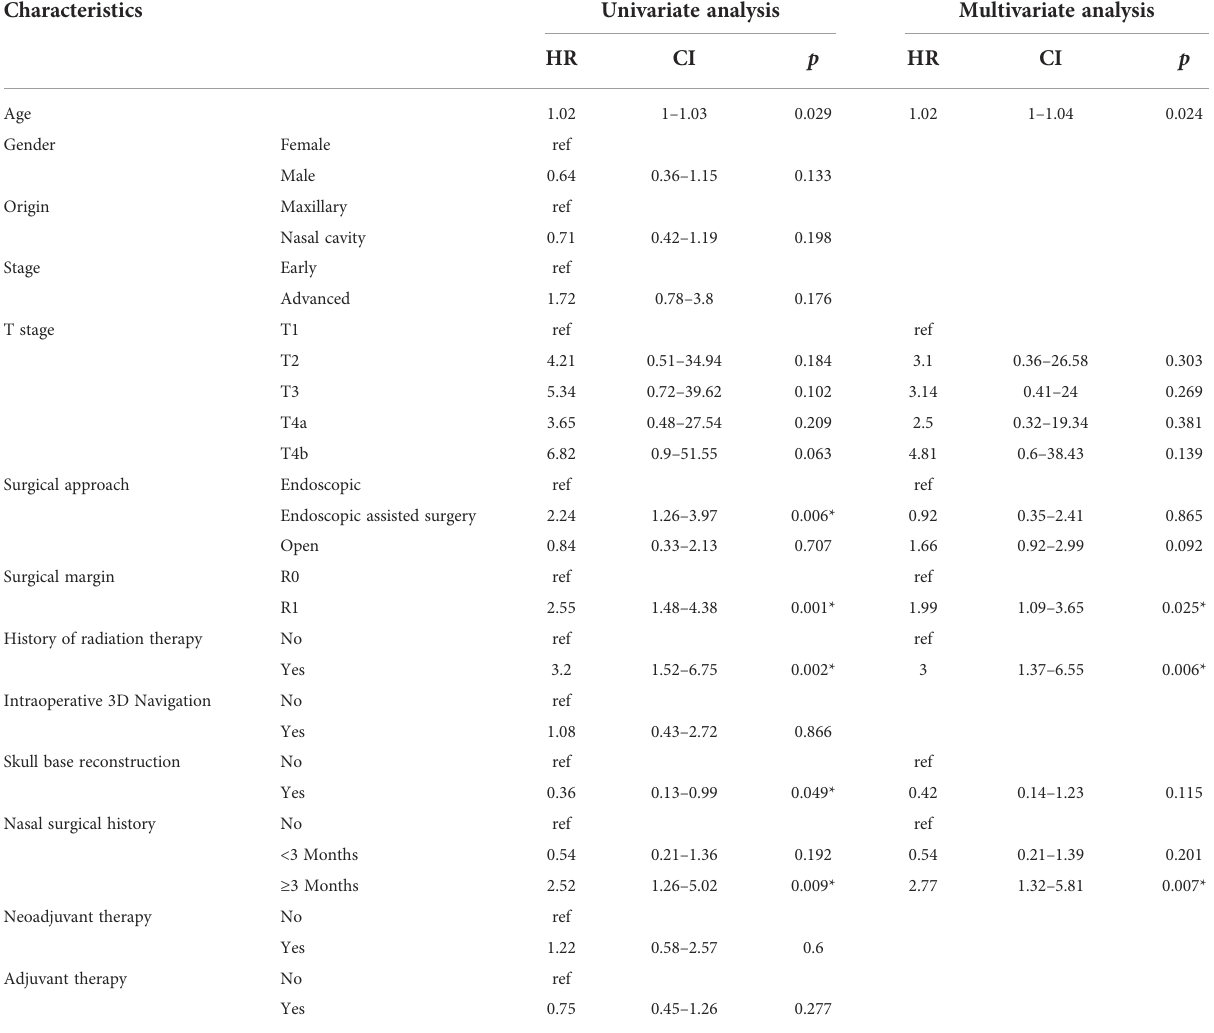
TABLE 2 Results of the univariable Cox regression analyses for event-free survival of SNM patients.